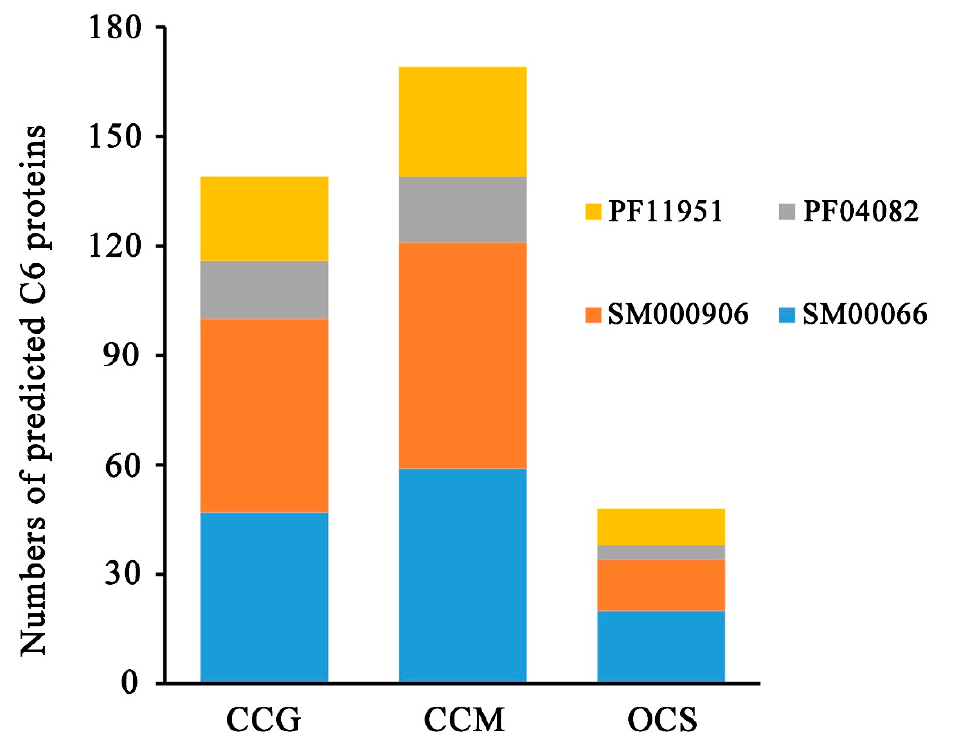
Figure 2. Classification of the identified C6 zinc proteins in T. guangdongense (CCG), C. militaris (CCM) and O. sinensis (OCS).